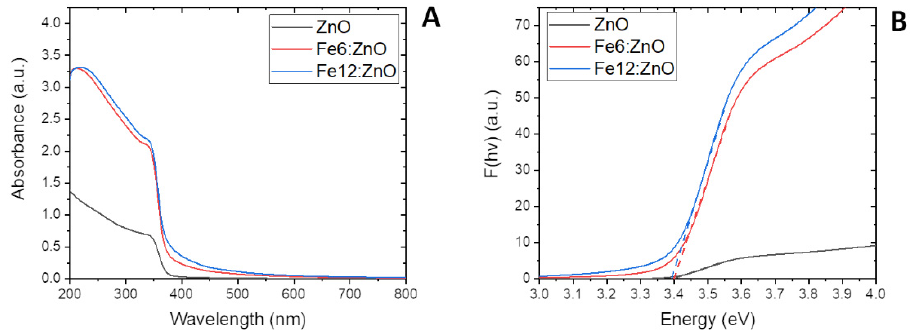
Figure 7. UV–visible spectra ( A ) and Tauc’s plot ( B ) of ZnO and Fe:ZnO NPs.